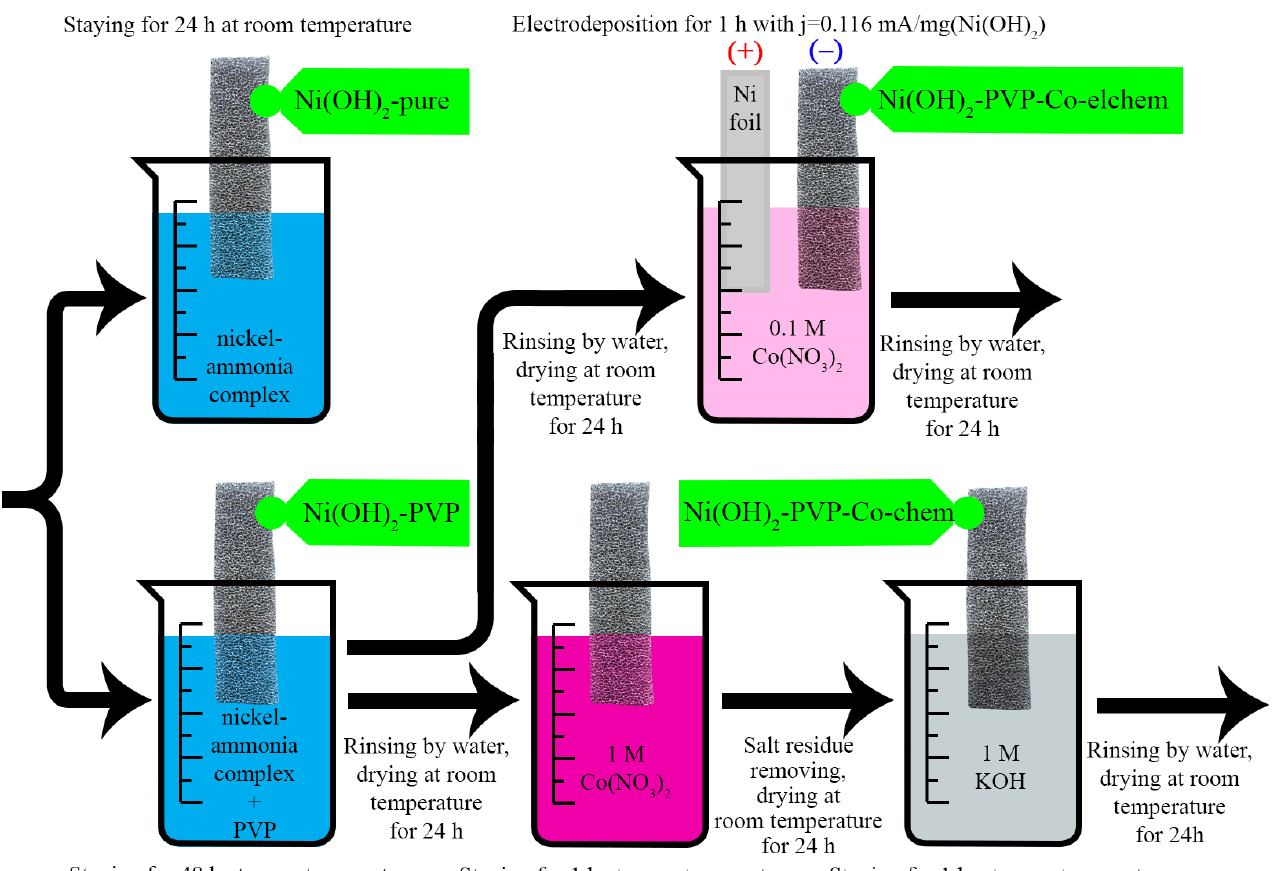
Figure 1. The general simplified scheme of the electrode formation. Detailed information about formation conditions is presented in Section 2.5.